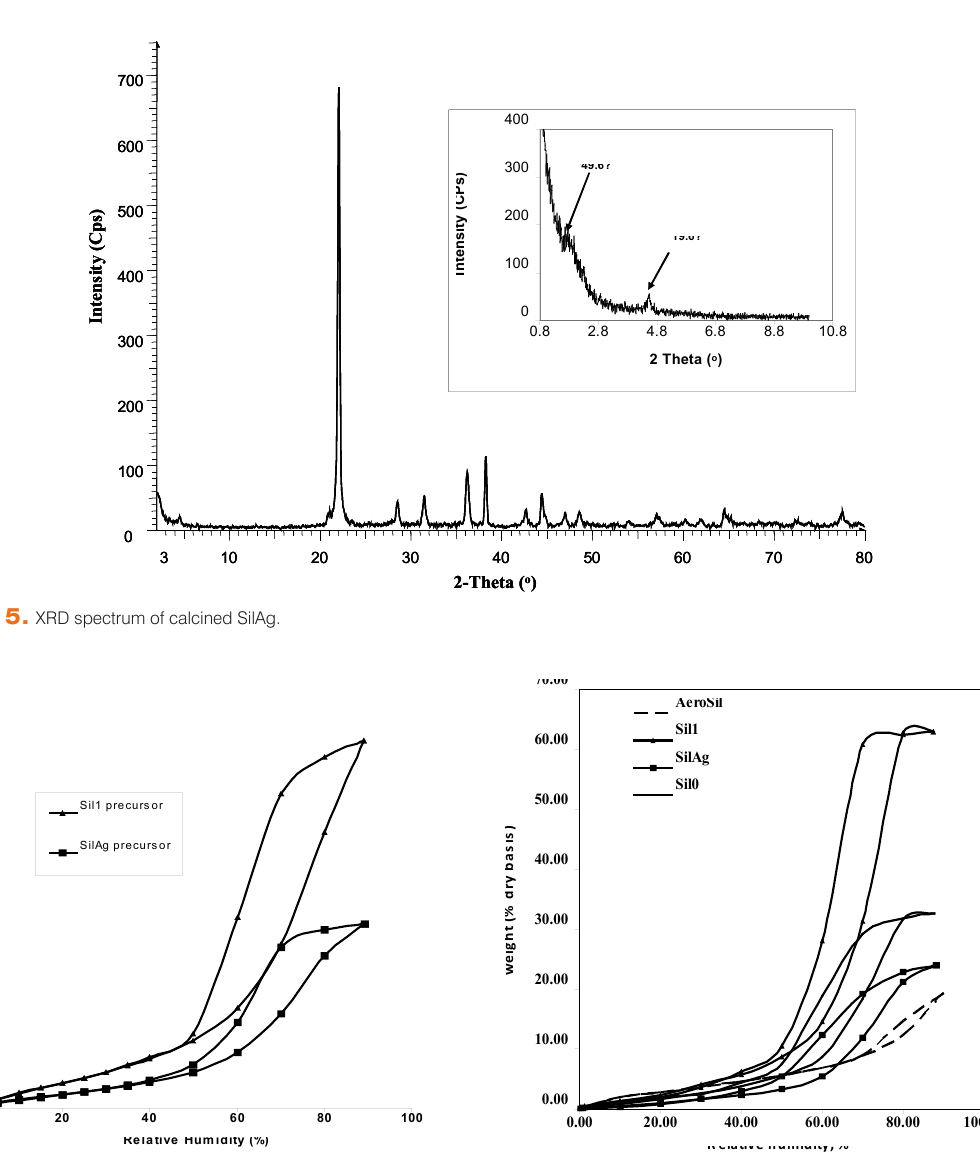
Figure 6. DVS behavior of the prepared silica materials: SilAg and Sil1 precursors before calcination (left); the calcined samples and Aerosil